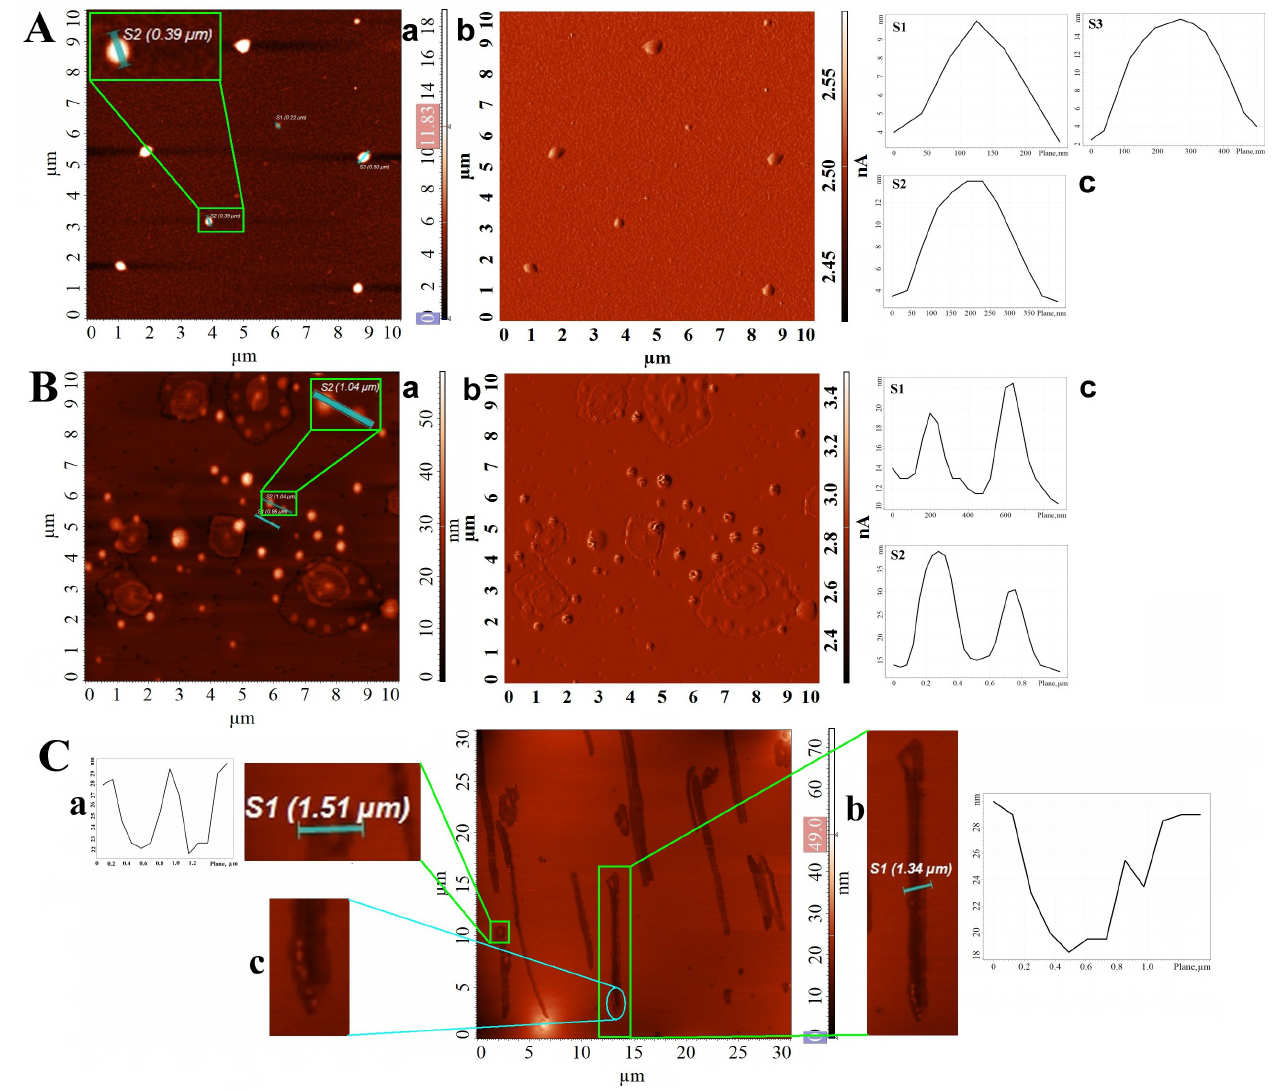
Figure 4. ( A ) AFM height ( a ) and amplitude ( b ) image of the round-shaped particles formed by drop-casting Th-OMeOx dispersion in water; ( c ) cross-sectional analysis of the particles shown in magnified insets in ( a ); ( B ) AFM height ( a ) and amplitude ( b ) image of the round-shaped particles formed by drop-casting Th-OMeOx dispersion in Chl; ( c ) cross-sectional analysis of the particles shown in magnified insets in ( a ); ( C ) AFM height image (middle panel) of self-assembled structures formed by drop-casting Th-OMeOx dispersion in THF; magnified height image and cross-sectional analysis of ( a ) round-shaped vesicle and ( b ) rod-shaped vesicle; ( c ) magnified area (4×) showing fusion of round-shaped small vesicles at the bottom of a rod-shaped vesicle. As can be seen from the data in Table 1, in water, the D h of micelles increased with increasing dispersion concentration. The only noted exception is for the value of c = 0.5